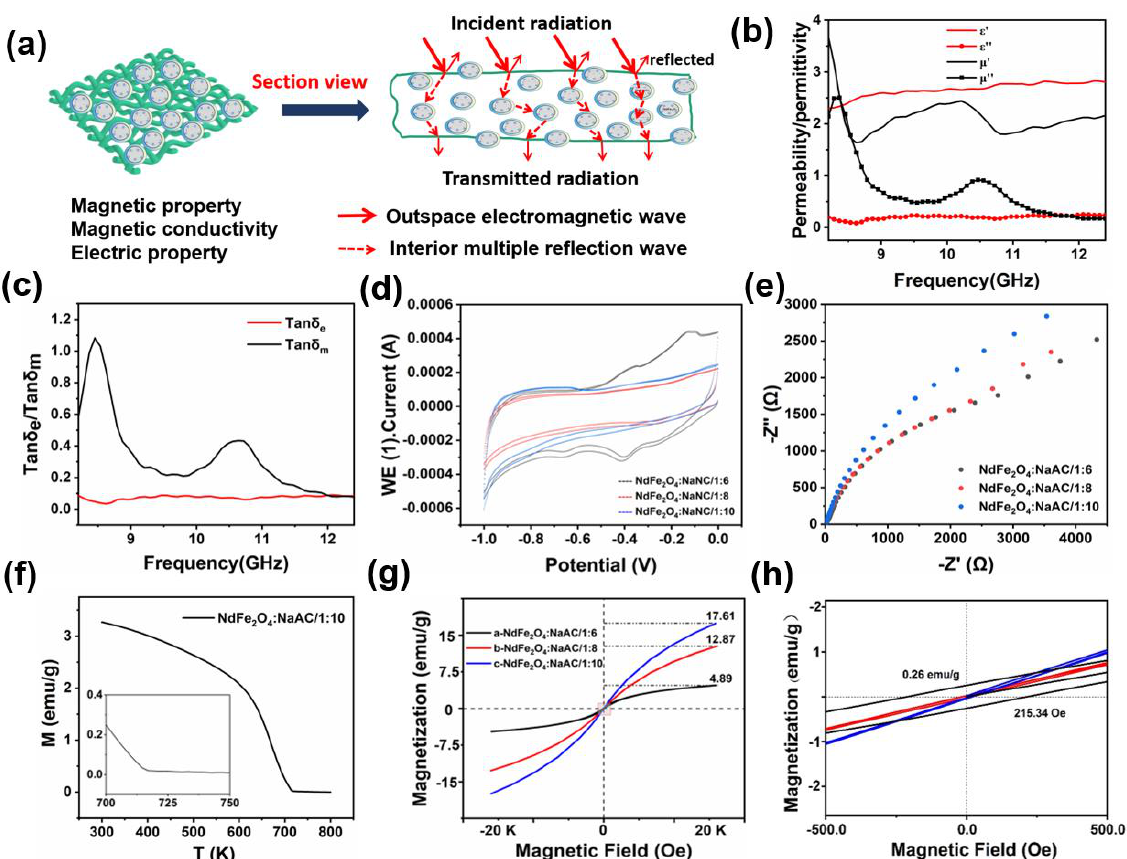
Figure 7. Illustration and electromagnetic properties of the functional fabrics. ( a ) The graphic mechanism of the functional fabrics; ( b ) electromagnetic parameters and ( c ) loss of the electromagnetic parameters; ( d ) CV curves and ( e ) double Ohm curves of the electrochemistry performance; ( f ) M−T curve, ( g ) M−H curves, and ( h ) enlarged M−H curves of the magnetic properties.